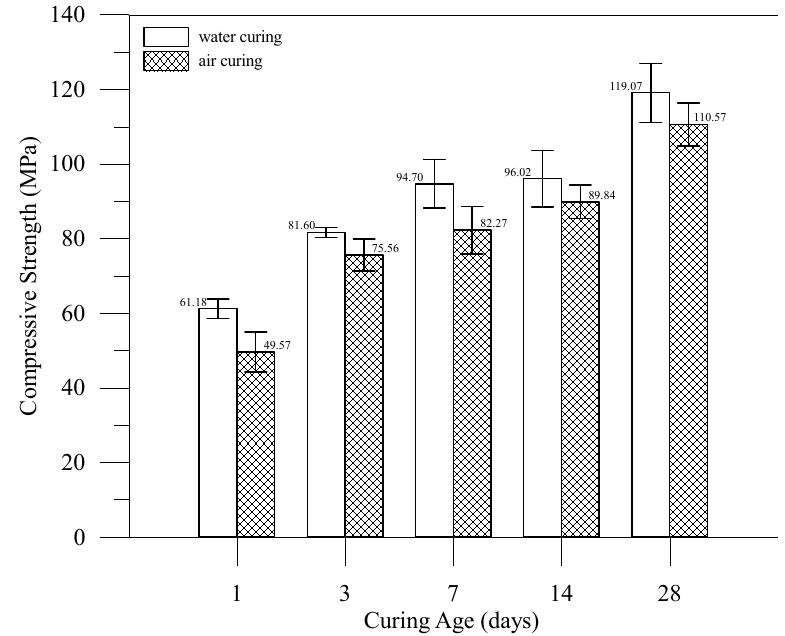
Figure 4. Histograms showing the compressive strength development.